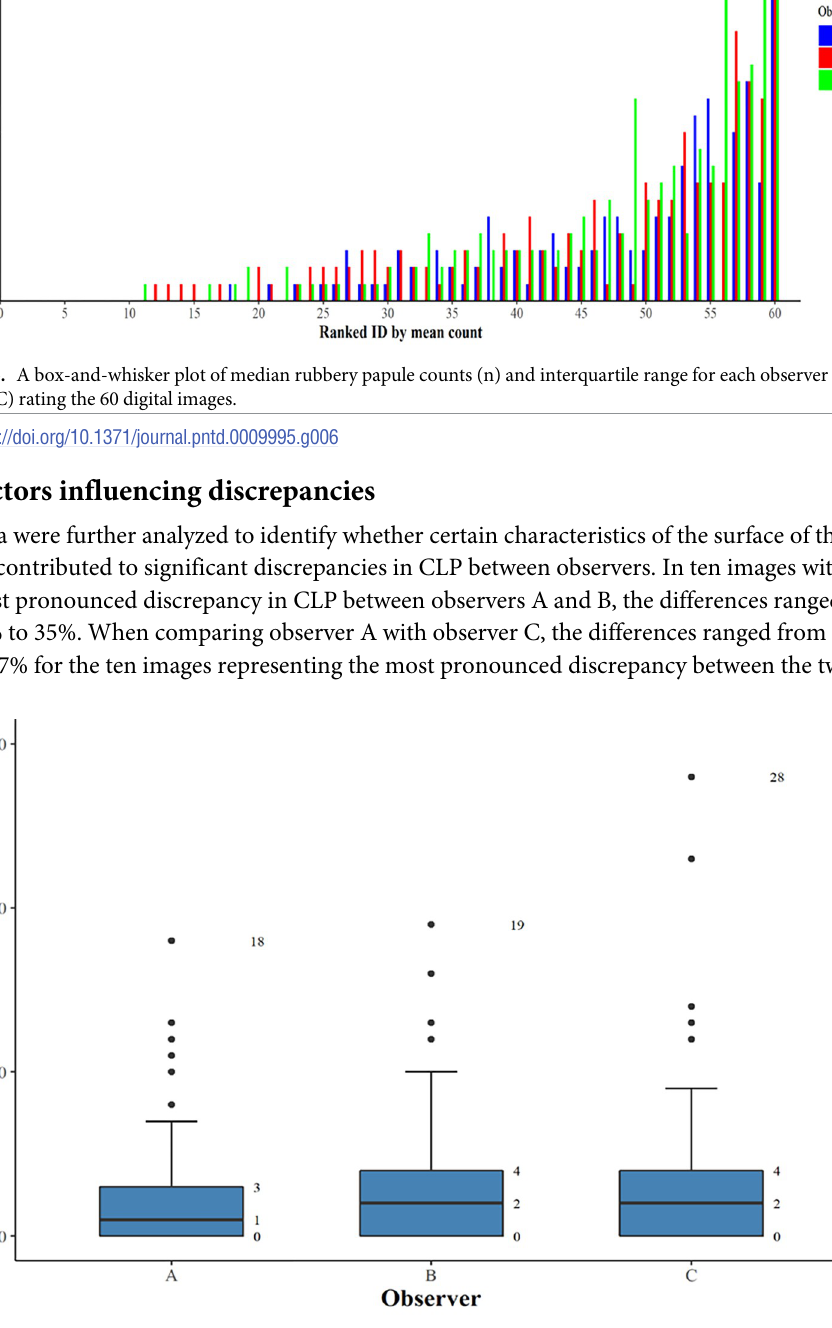
Fig 7. Distribution of rubbery papule count (n) for the 60 digital images as rated by the three observers and ranked in accordance with the respective individual mean values.